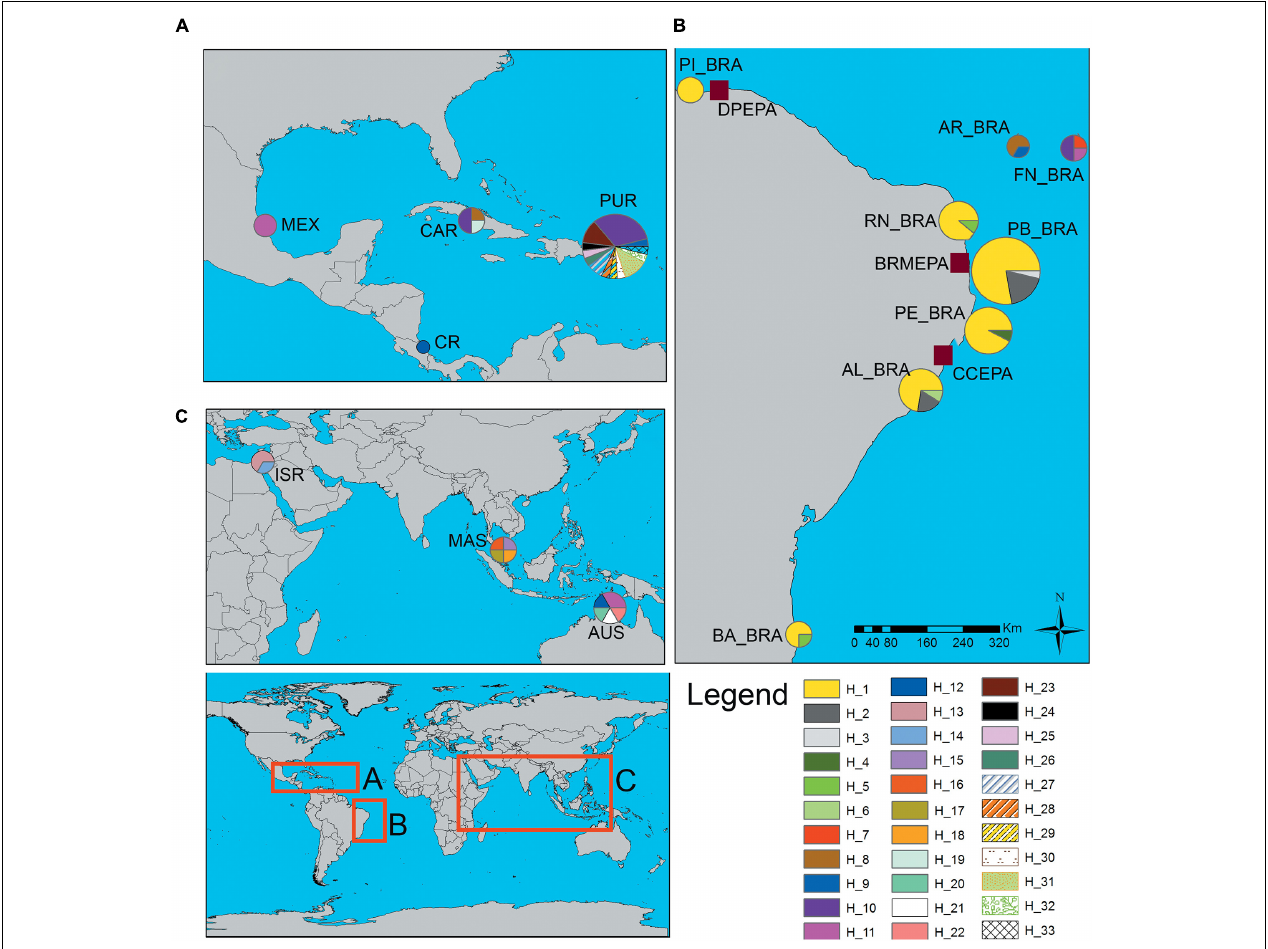
FIGURE 1 | Map showing the location of the 15 populations of Eretmochelys imbricata evaluated and the spatial distribution of the 33 haplotypes recorded in the study. Each color represents a haplotype, the thickness being proportional to its frequency in each population. (A) Costa Rica—CR; Mexico—MEX; Caribbean—CAR; Puerto Rico—PUR. (B) Bahia—BA_BRA; Alagoas—AL_BRA; Pernambuco—PE_BRA; Paraíba—PB_BRA; Rio Grande do Norte—RN_BRA; Piaui—PI_BRA; Atol das Rocas—AR_BRA; Fernando de Noronha—FN_BRA. Location of Protection Areas: Costa dos Corais Environmental Protection Area (CCEPA); Barra do Rio Mamanguape Environmental Protection Area (BRMEPA); Delta Parnaíba Environmental Protection Area (DPEPA). (C) Australia—AUS; Malaysia—MAS;